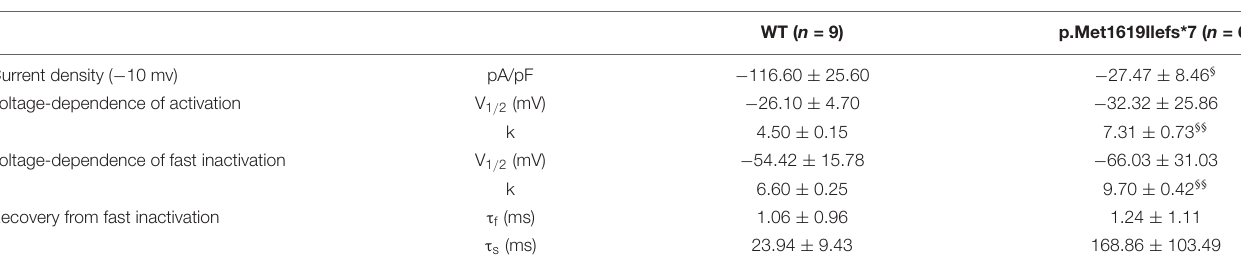
FIGURE 3 | Electrophysiological analysis of the SCN1A in-frame deletion and truncated mutants. (A) Representative traces of sodium current evoked at 0 mV. (B) Current-voltage relationship of six in-frame deletion mutants. (C) Current-voltage relationship of the truncated mutant. (D) G-V activation curve, (E) steady-state inactivation curve, and (F) recovery from inactivation, all for the truncated mutant p.Met1619Ilefs ∗ 7. Non-transfected cells were used as negative control. TABLE 3 | Biophysical parameters of truncating mutant